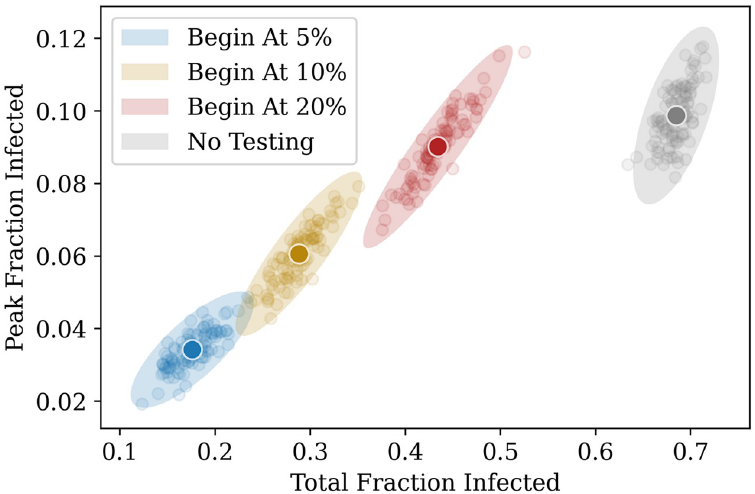
Fig 5. Another representation of Fig 4A. The daily test rate is fixed at 0.5% of the population per day, and testing is started at different fractions. The x –axis represents the total fraction who have contracted the illness by the end of the pandemic, and the y –axis represents the peak infected fraction. Each point represents the result of a single simulation. A total of 100 simulation runs of 200 days each were performed for each case. The ellipses are centered around the average point (highlighted) and their radii represent 3 standard deviations of the distribution across